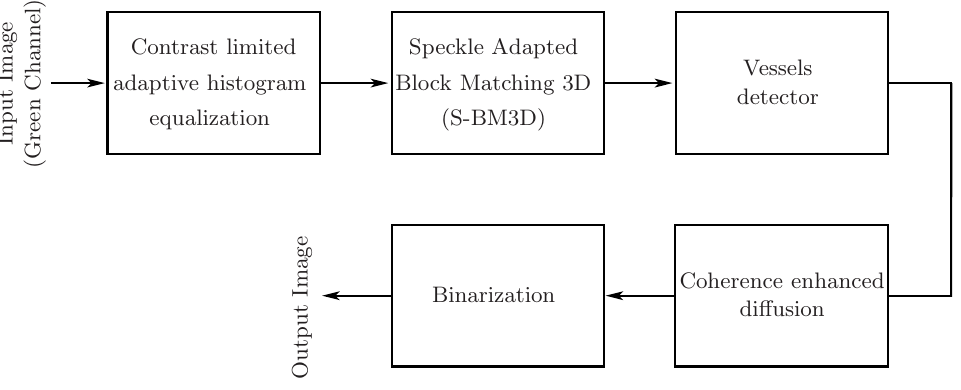
Figure 1. Block diagram of the proposed retinal vessel segmentation